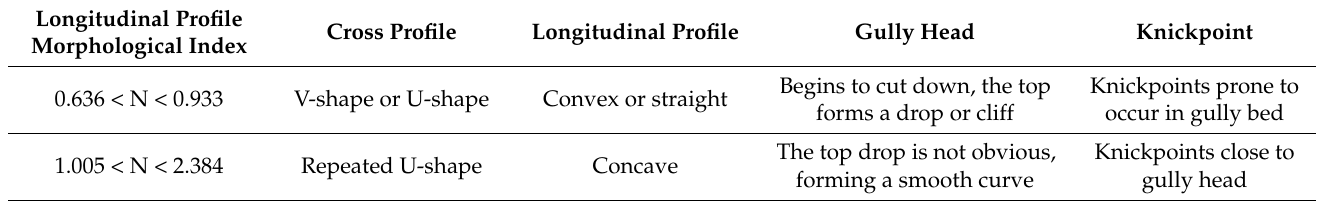
Table 4. Characteristics of gully development in different developmental